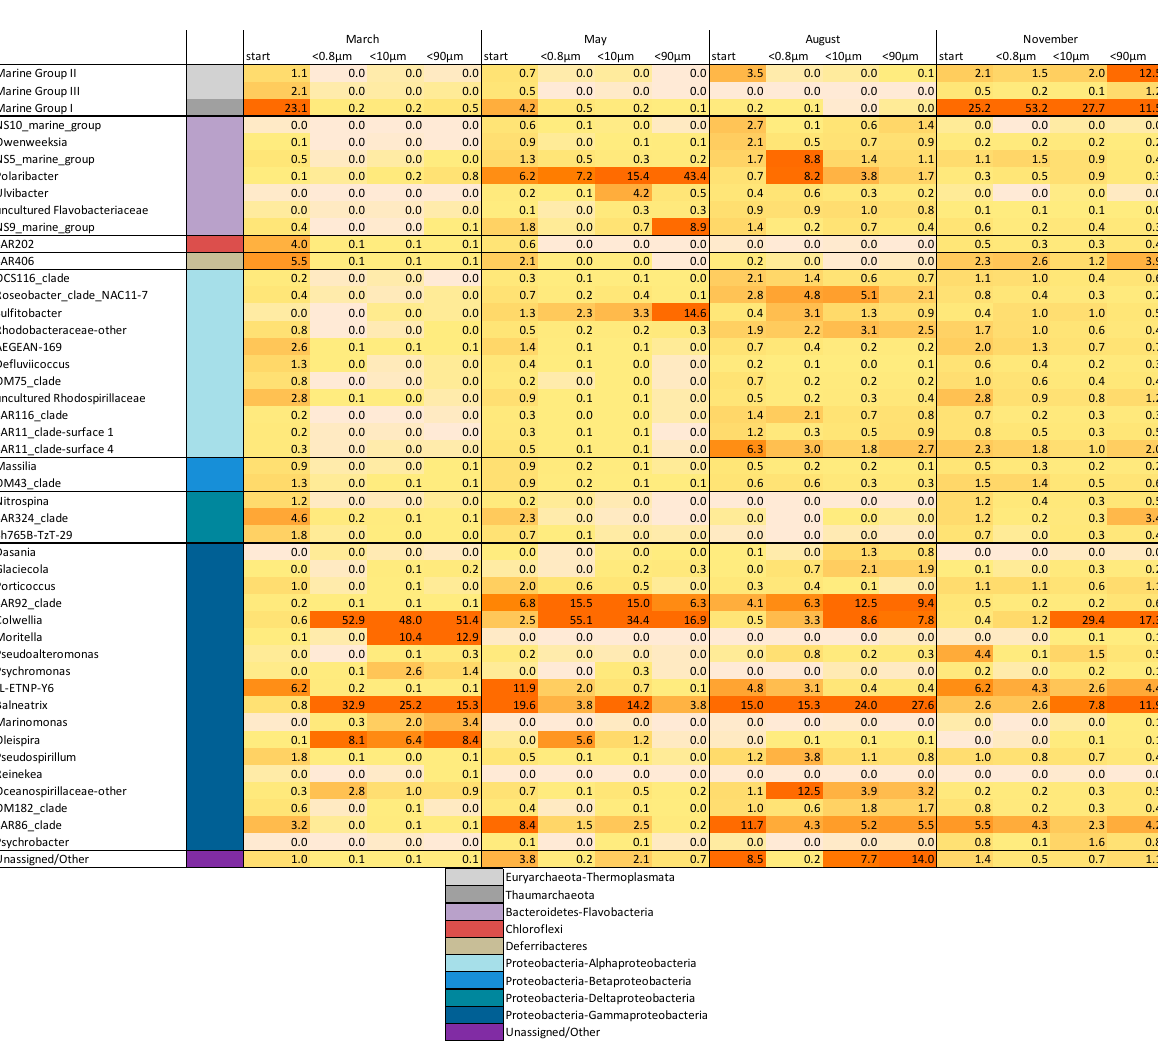
Figure 6. Heat map showing the changes in relative abundance of the highly represented (relative abundance >1%) bacterial taxa (genus level) based on 16S rRNA gene sequencing from the start to the end of the incubation for the different size fractions (<0.8- µ m, <10- µ m and <90- µ m). Relative abundance is indicated as a percentage and illustrated by a shade of orange, with dark shades for high and light shades for low values. The phylum and class level, if relevant, are indicated via a color code on the lower right-hand Figure 6: Heat map showing the changes in relative abundance of the highly represented (relative abun- 387 dance > 1 %) bacterial taxa (genus level) based on 16S rRNA gene sequence from the start to the end of 388 the incubation for the different size classes (<0.8 µm; <10 µm; <90 µm). Relative abundance is indicated 389 as percentage and illustrated by the shade of orange with dark shades for high and light shades for low 390 values. Phylum and class level if relevant are indicated via a color code on the lower right-hand side. 391 To evaluate changes in metabolic potential we used community composition (16S 392 rRNA gene data) at the start and end of the experiments to predict and quantify metabolic 393 pathways in terms of KEGG Orthology (KO) abundance using the Tax4Fun package in R (Figure A3). In March and May, almost all metabolic pathways had an increase in genes 395 associated to them at the end of the experiment. The opposite was evident for the experi- ments in August and November when the number of KO`s assigned to the most abundant metabolic processes decreased by the end of the experiment. The pathways with the high- est increase, were the Two component system, Biosynthesis of secondary metabolites, ABC transporters, Biofilm formation and Quorum sensing in the May experiment. The